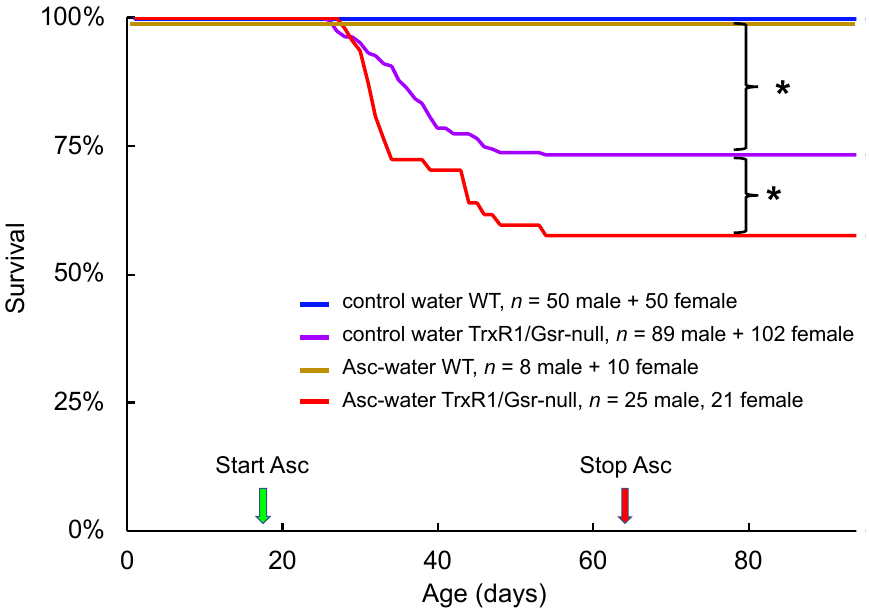
Figure 1. Impact of supplemental ascorbate on survival. Mice with WT or TrxR1/Gsr-null livers were raised on plain acidified drinking water (control) or acidified drinking water containing 5 mg/mL ascorbate (Asc-water) from weaning (P19, green arrow) until P63 (red arrow). The number and sex of animals represented is indicated; sexes did not differ significantly ( p > 0.05) in any of the six groups (not shown). Brackets and asterisks, p ≤ 0.05, by log rank analysis.